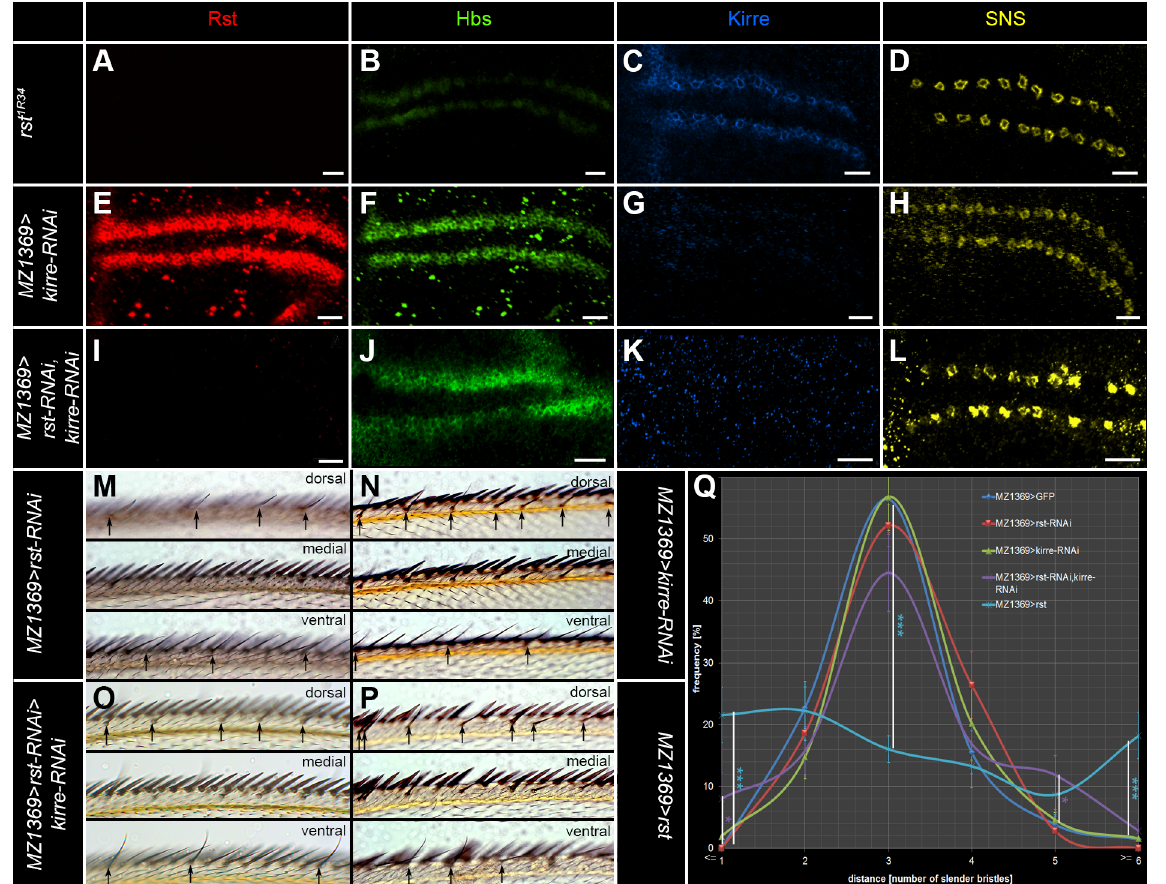
Fig 2. Rst acts cooperatively with Kirre to secure the bristle pattern in the anterior wing margin. (A-L) Projection views of IRM-protein immunoreactivity in late third instar larvae. Rst is shown in red (A, E, and I), Hbs in green (B, F and J), Kirre in blue (C, G and K) and SNS in yellow (D, H and L). (A-D) The rst allele rst 1R34 shows no detectable Rst staining (A). (B) Hbs staining is reduced in the membranes surrounding the SOPs and is mainly detected in SOP membranes. Kirre (C) and SNS (D) show no significant pattern change. (E-H) MZ1369-GAL4 > UAS-kirre-RNAi shows no significant changes of the Rst (E) and Hbs pattern (F). Kirre immunoreactivity is hardly detectable (G) while SNS (H) is mildly reduced. (I-L) In the rst , kirre double RNAi hardly any Rst (I) and Kirre (K) can be detected. Enrichment of Hbs (J) around SOPs is reduced and the SOP arrangement as seen with SNS (L) is severely disrupted. (M) In the adult MZ1369 > rst-RNAi shows a mild spacing phenotype with spacing ranging from 2 to 5 intervening bristles. (N) MZ1369 > kirre-RNAi shows a mild spacing phenotype with spacing ranging from 1 to 7 (similar data was obtained for the mutant rst 1R34 , data not shown). (O) MZ1369 > rst-RNAi , kirre-RNAi shows a significant disturbance of the spacing of recurved bristles with 0 to 8 intervening cells. (P) MZ1369-GAL4 misexpression of rst has a strong impact on the spacing of recurved bristles with spacing ranging from 0 to 13 intervening cells. Clustered recurved bristles are frequently observed and similarly long areas without any chemosensory bristles are seen. (Q) shows the quantitative analysis of the recurved bristle spacing as measured by the number of slender bristles between the recurved bristles. The distribution of MZ1369 > GFP differs significantly from MZ1369 > rst-RNAi , kirre-RNAi in the following spacing values: < = 1: p-value = 0.034, 5: p-value = 0.041. MZ1369 > rst differs significantly in the following spacing values: < = 1: p-value = 0.0002, 3: p-value = 0.0002, > = 6: p-value = 0.0001. Scale bars correspond to 10 μ m in all